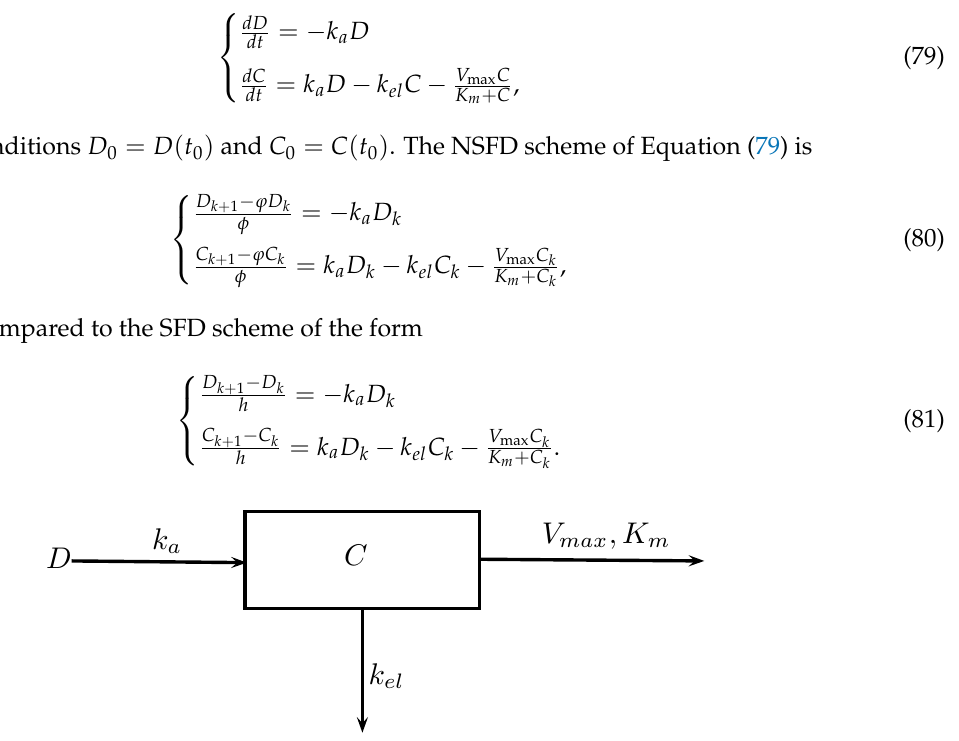
Figure 6. Schematic presentation of extravascular administration with both linear and Michealis-Menten